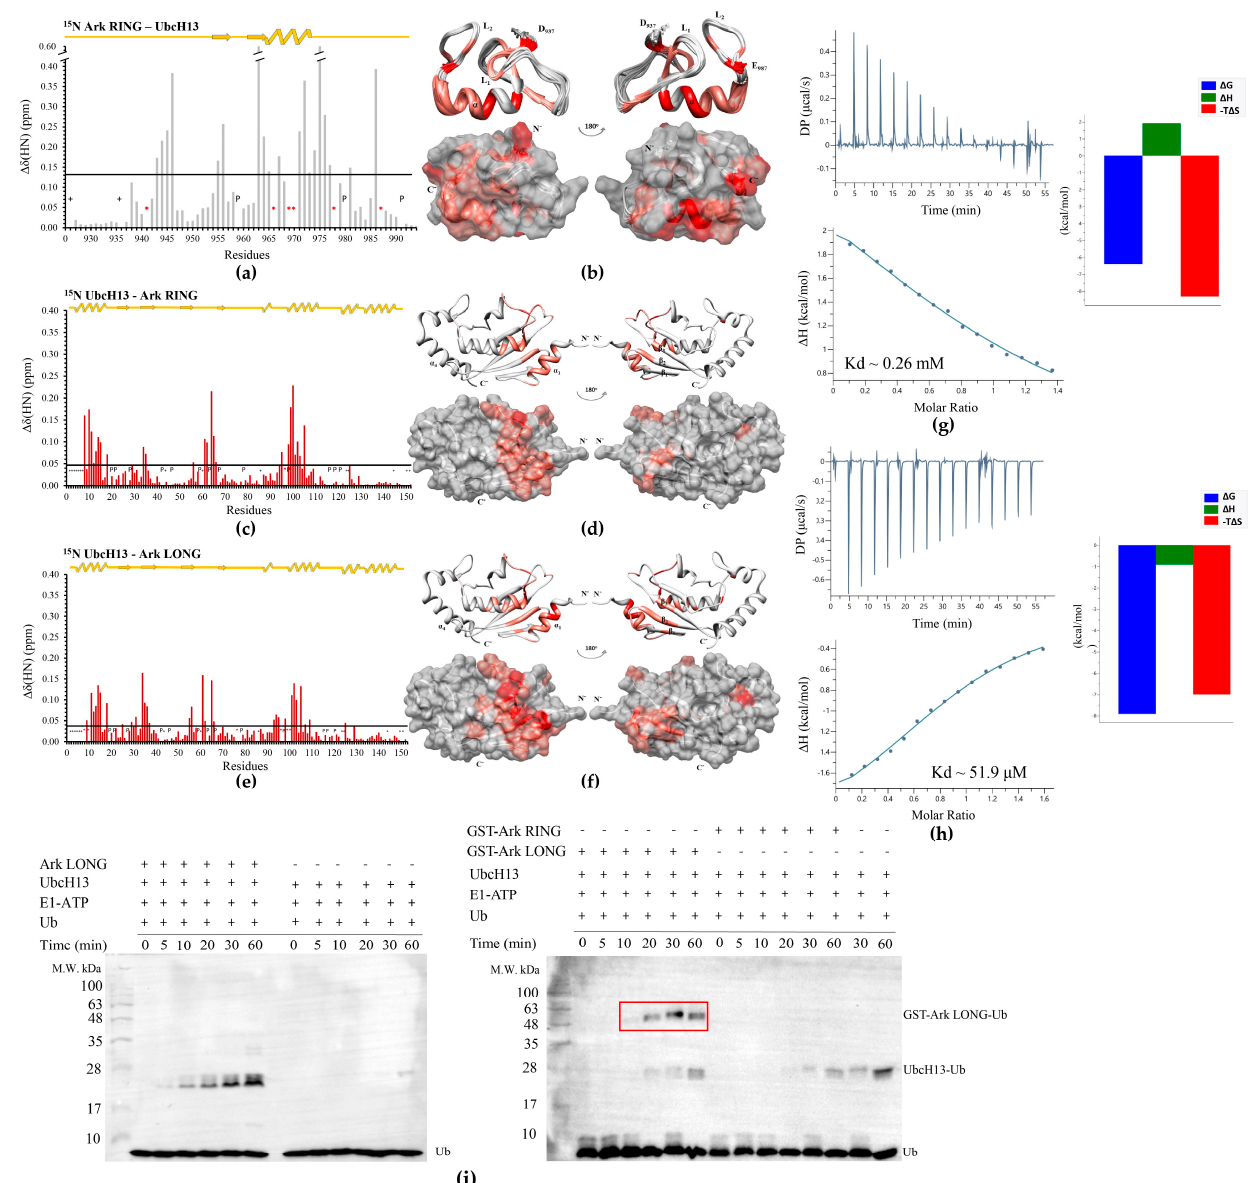
Figure 6. Interaction of E3 Arkadia with UbcH13 E2 enzyme. ( a ) Diagram of the total CSPs measured at a 1:2 molar ratio (saturation point) for 15 N Ark RING/ 14 N UbcH13, *: represents disappeared residues, +: represents residues with no information. ( b ) Ark RING mapping (PDBid: 2KIZ) after the addition of UbcH13 (residues that disappeared during the interaction are colored red, whereas residues that exhibited ‘fast exchange’ interaction are colored coral). ( c ) Diagram of the total CSPs measured at a 1:2 molar ratio for 15 N UbcH13/ 14 N Ark RING. ( d ) UbcH13 mapping (PDBid: 1J7D) after the addition of Ark RING. ( e ) Diagram of the total CSPs measured at a 1:2 molar ratio for 15 N UbcH13/ 14 N Ark LONG. ( f ) UbcH13 mapping (PDBid: 1J7D) after the addition of Ark RING. ( g ) ITC data for the titration of UbcH13 into Ark RING and ( h ) into Ark LONG. ( i ) In vitro auto-ubiquitylation assays using UbcH13 in the presence and absence of Ark LONG ( left ) and in the presence of GST-Ark LONG or GST-Ark RING ( right